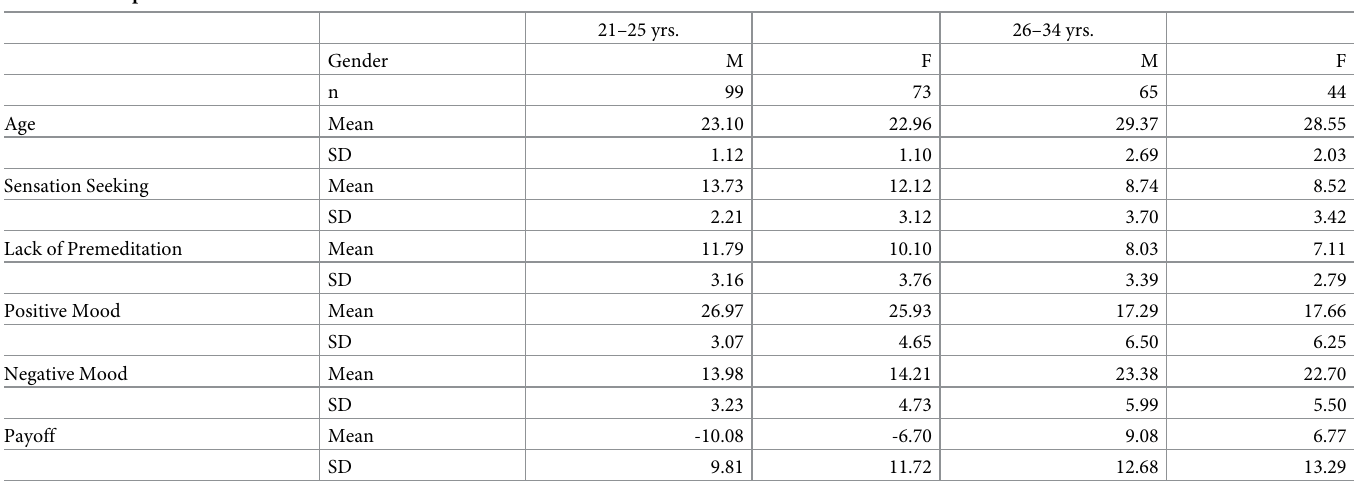
Table 1. Descriptive statistics.